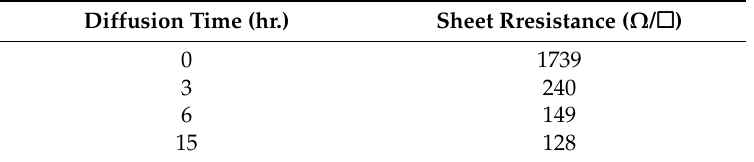
Table 1. Sheet resistance of Cu doped ZnO samples with different diffusion times. Diffusion Time